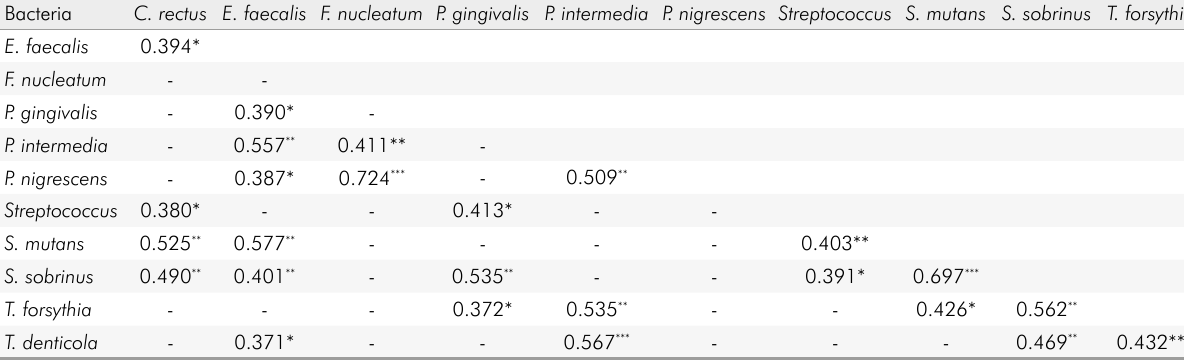
Table 3. Correlation ( r ) between the densities of the bacteria tested in this study.